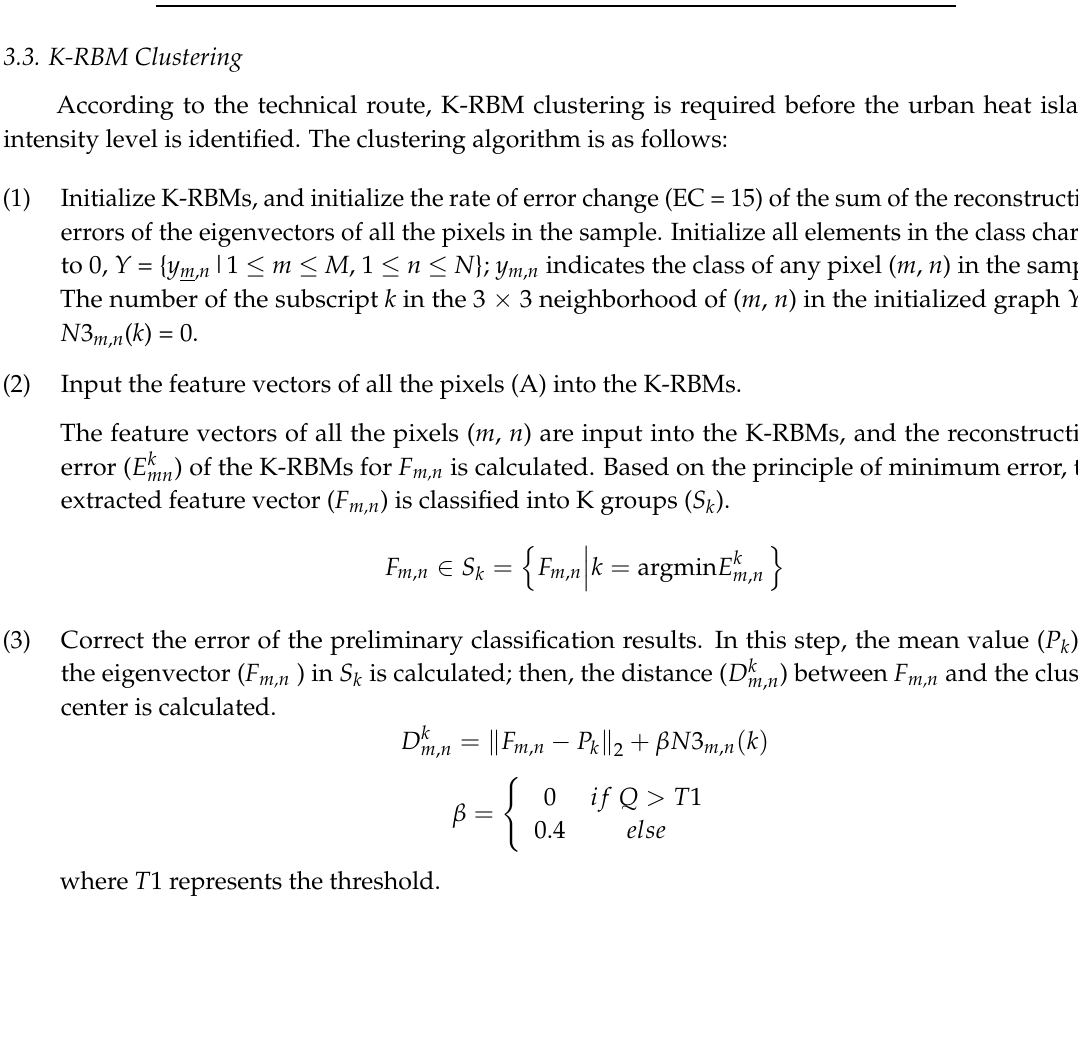
and r 2 are the 10 11